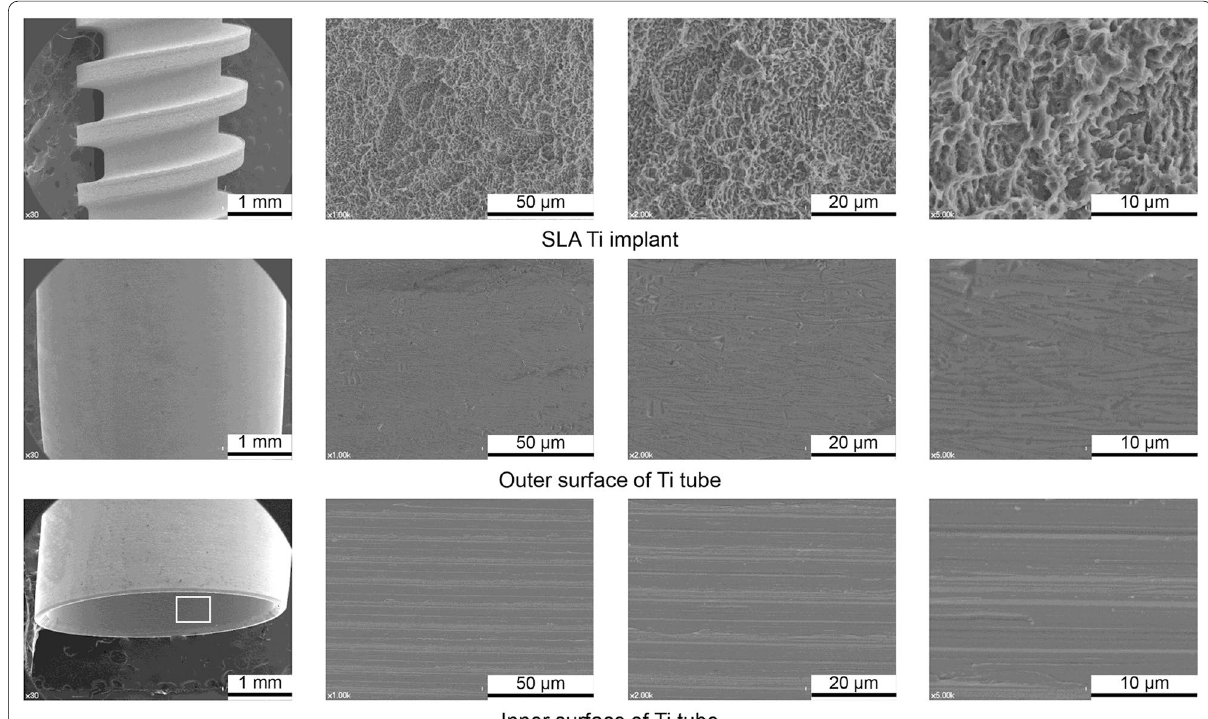
Fig. 2 Surface characteristics of SLA Ti implants and turned Ti tubes. Representative scanning electron microscopy images of the SLA Ti implants and the turned Ti tubes. The white rectangle indicates the inner surface of the Ti tube